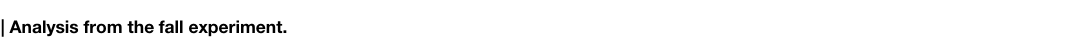
TABLE 2 | Analysis from the fall